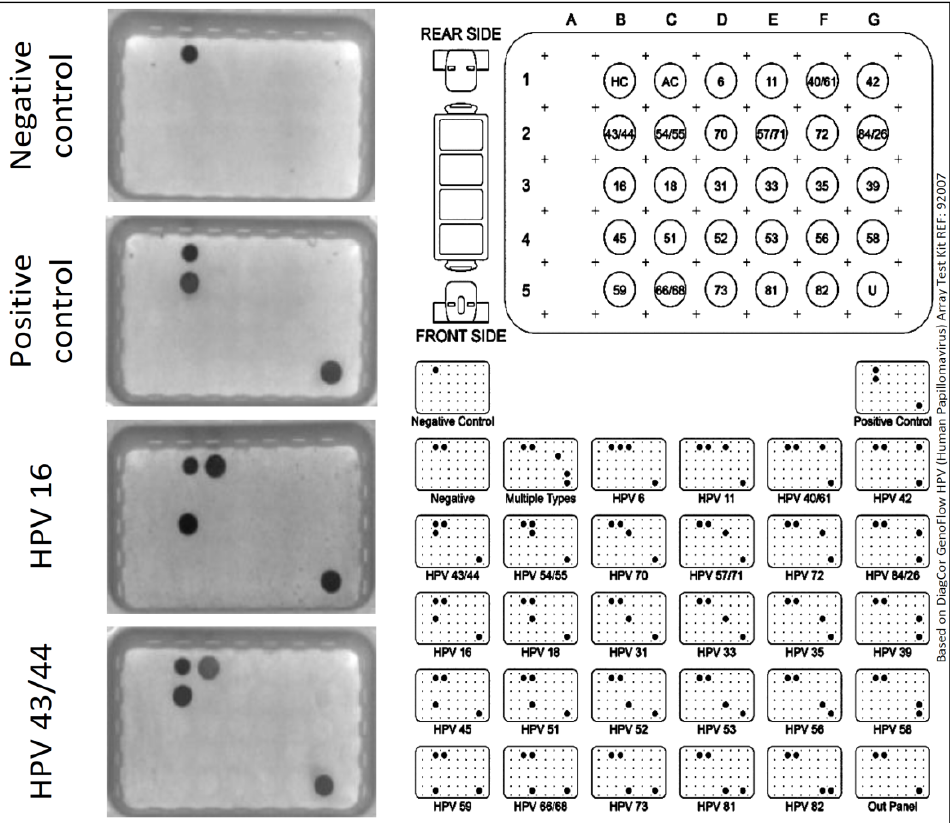
Figure 1. Example of HPV detection by hybridization, with the results for negative and positive controls and HPV 16 and HPV 43/44 positive samples.